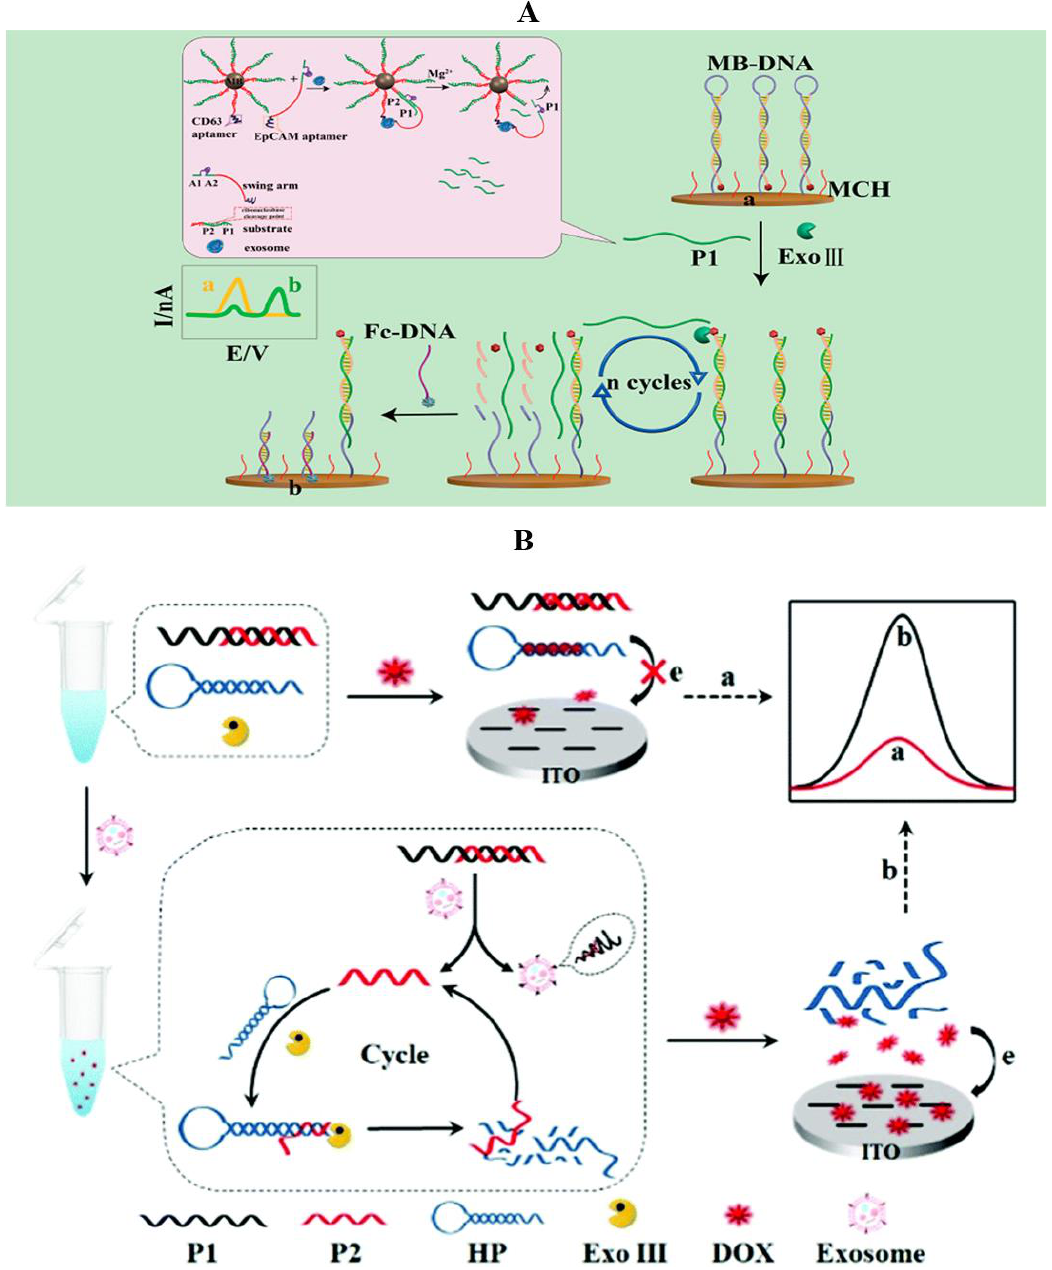
Figure 8. Detection of exosomes in breast cancer by the electrochemical method (general material). ( A ) Schematic illustration for the detection of exosomes through 3D DNA walker amplification and Exo III-assisted electrochemical ratiometric assay [137]; ( B ) principle of the aptamer recognition- trigged label-free homogeneous electrochemical strategy for the ultrasensitive detection of cancer- derived exosomes [142].